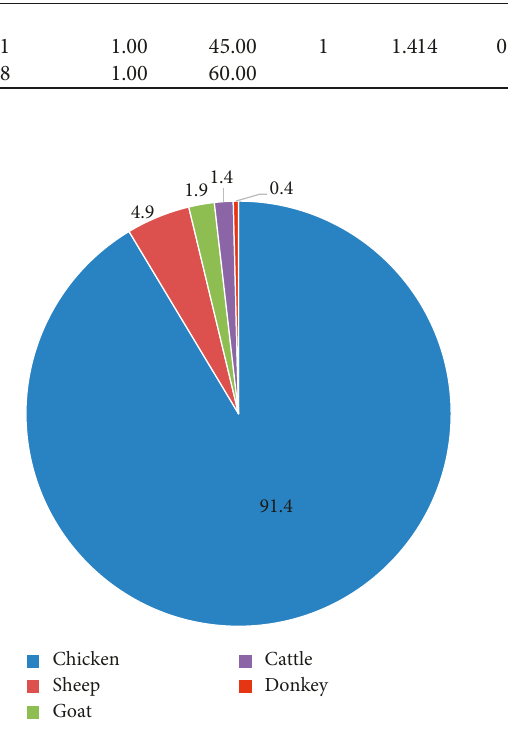
Figure 4: Percentages of animals’ loss within three years of the study